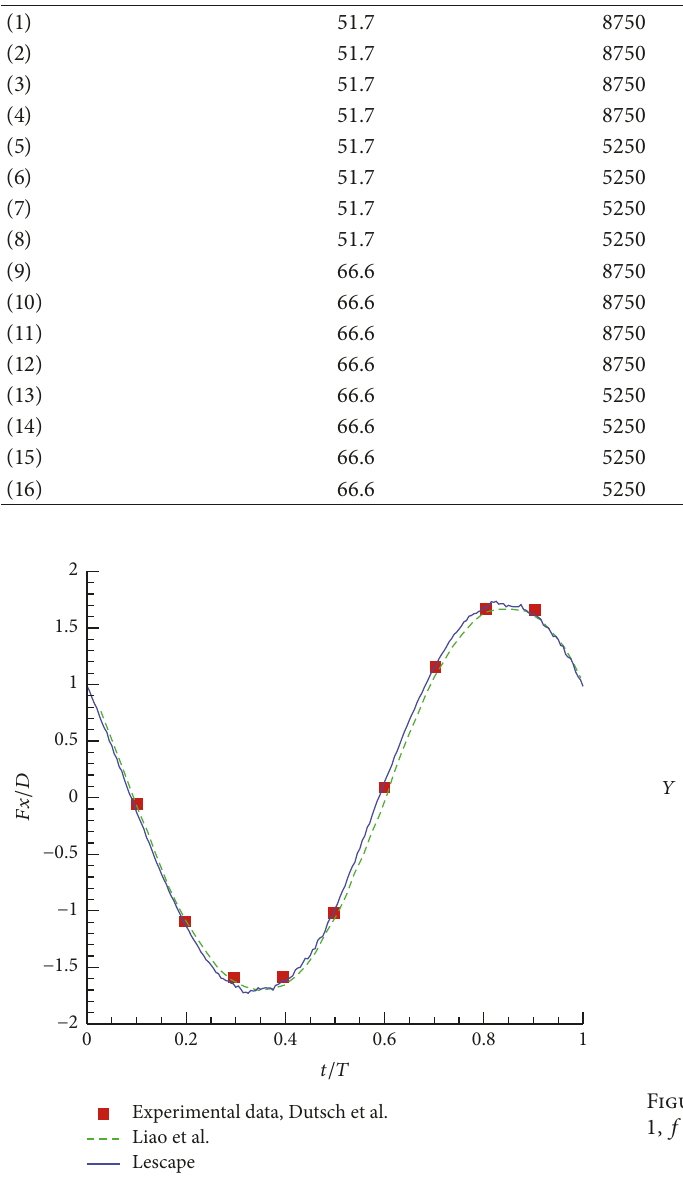
Figure 6: Comparison of the drag force obtained using the present CFD code, Lescape, with [14] and experimental results taken from [13].